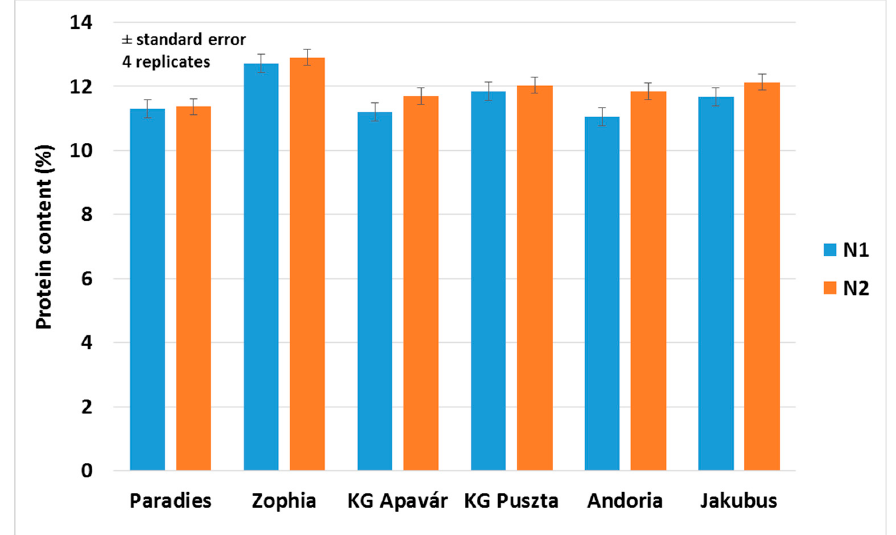
Figure 12. Protein content of winter barley cultivars in connection to N-supply (Debrecen, 2020). Standard error of means, 4 replicates. The positive effect of higher N level on protein content has not been proved, protein content was determined genetically. N1: N 90 P 45 K 50 ; N2: N 150 P 45 K 50 kg ha − 1. We calculated the protein yield of barley for each plot using yield and protein content data.